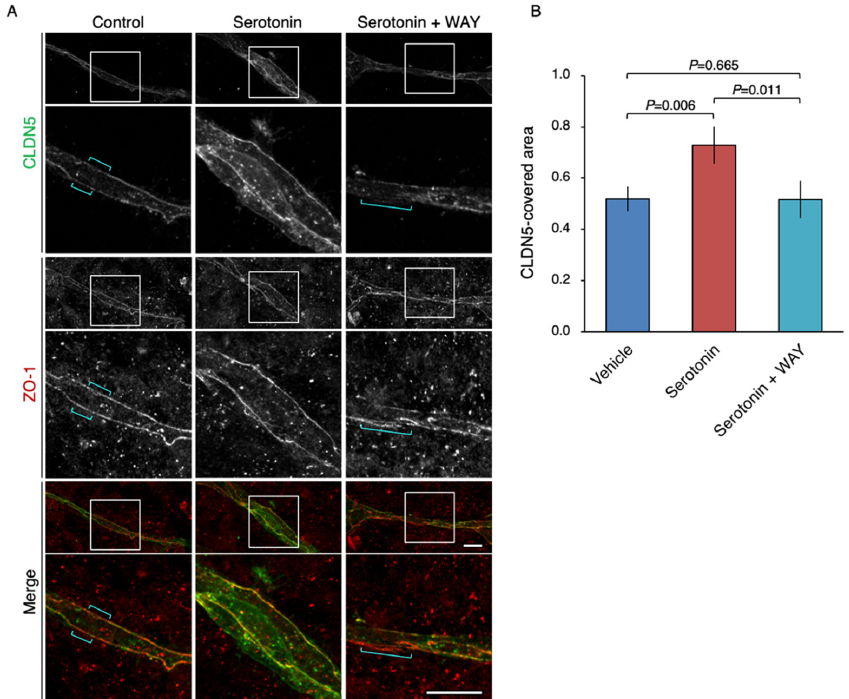
Figure 6. Up-regulation of the CLDN5-immunoreactive area in the microvascular endothelial tube-like structure via the serotonin/5-HT1A receptor signaling. ( A ) Confocal images of two-dimensional co-culture stained for CLDN5 and ZO-1. The HBPCT and the human primary BMVECs were grown under two-dimensional co-culture conditions for 4 days. Brackets indicate the breakdown of CLDN5. WAY: WAY-100635. Scale bars, 50 µm. ( B ) The CLDN5-length is divided by the ZO-1-length, and the relative CLDN5-covered area is shown in histograms (mean ± SD; n = 3). Similar results were obtained from three independent experiments.